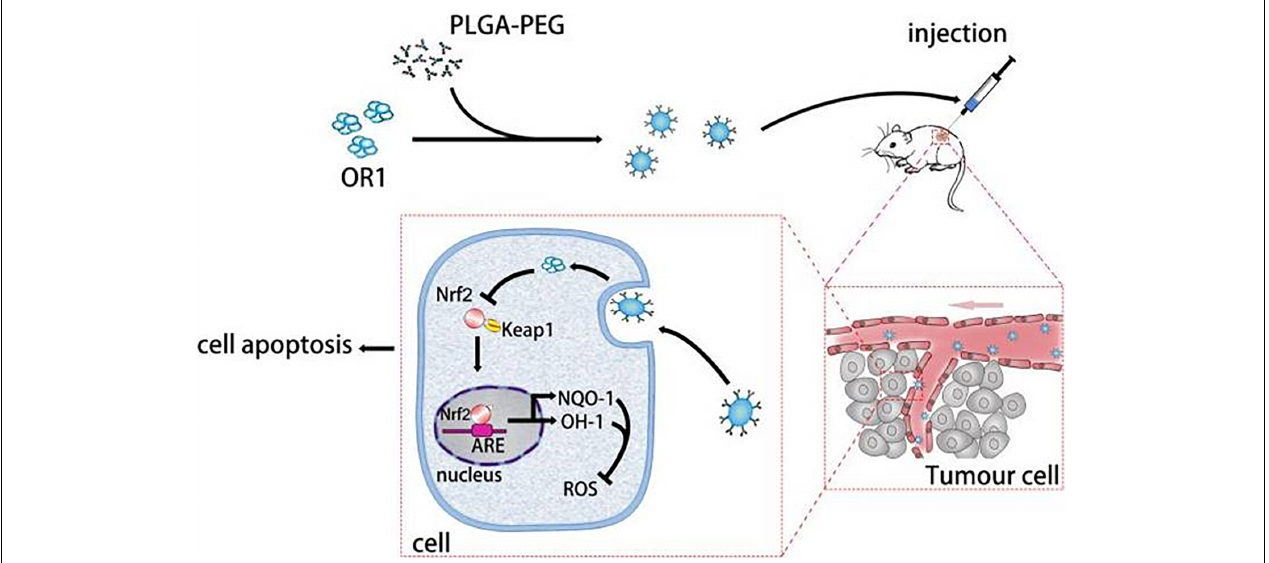
FIGURE 7 | Schematic illustration of the ORI-NPs theranostic nanoplatform.